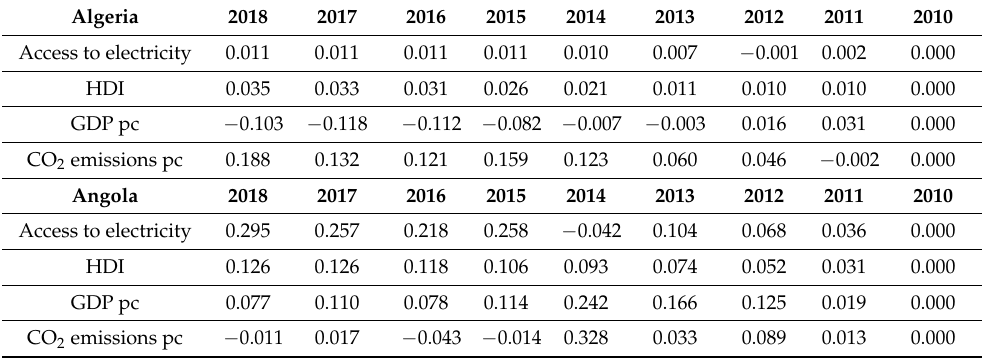
Table 5. The results of the second stage of standardization for model (a) for two selected African countries. Source: own calculations.